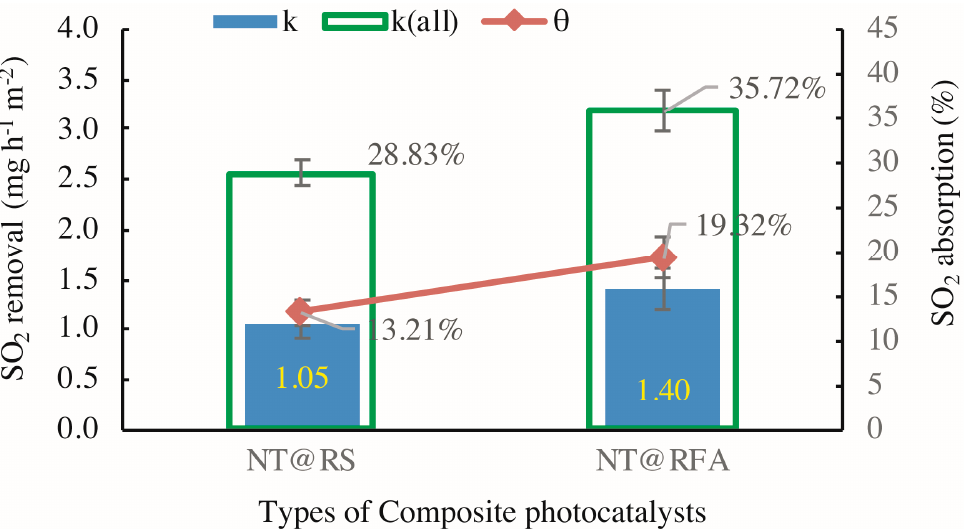
Figure 7. SO 2 degradation in presence of CP-incorporated specimen: the detected quantitative SO 2 removal of samples containing di ff erent CPs ( k means k 1 in Equation (2) and k (all) means k 2 in Equation